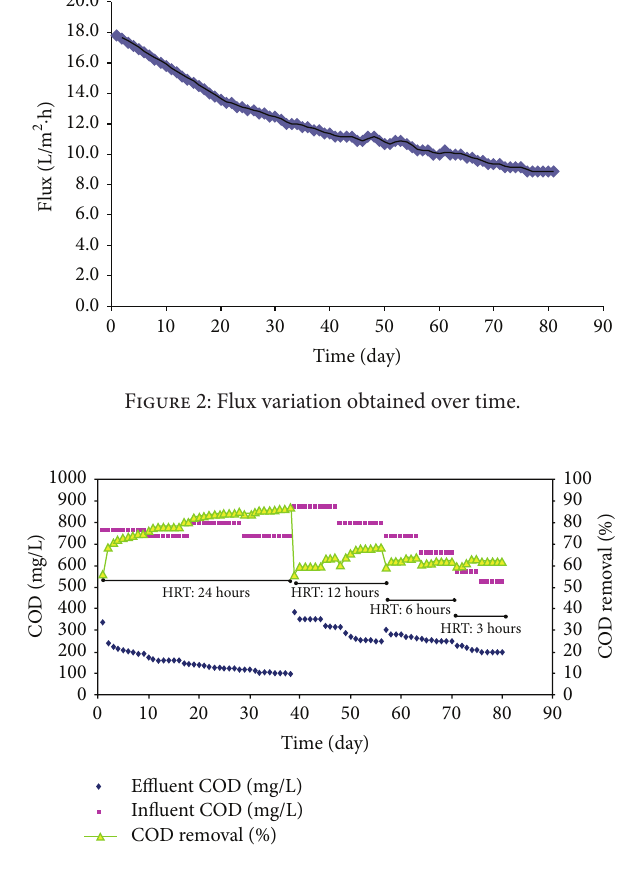
Figure 3: COD removal efficiency.